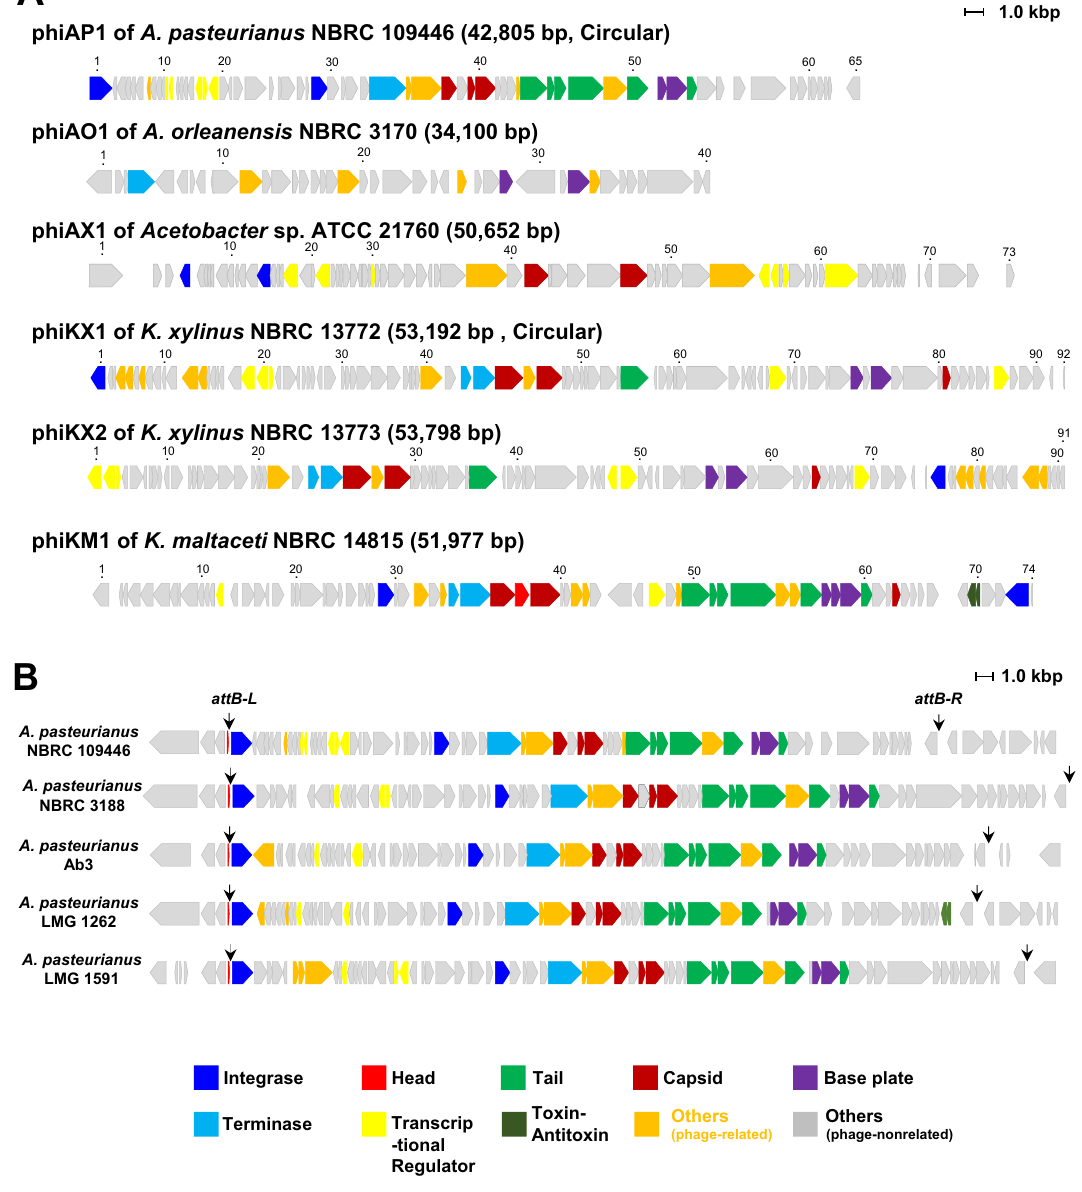
Figure 2. Schematic representation of temperate phage genomes in AAB. ( A ) Genome structure and gene organization of the temperate phages determined in this study. Number above arrow represent ORF number in each temperate phage (annotations for each gene product are shown in Table S4). Numbers in parentheses indicate the genome size and structure of the phages. ( B ) Distribution of phiAP1-like prophage elements in the genomes of A. pasteurianus strains. Downward arrowheads indicate the putative attB-L and attB-R Figure 2A shows the predicted gene organization based on phage genome information. Genome sizes range from 34,100 to 53,798 bp. Circular genome were confirmed in phiAP1 and phiKX1. The molecular G + C content of each genome is 52.4% for phiAP1, 61.4% for phiAO1, 56.0% for phiAX1, 60.2% for phiKX1, 60.0% for phiKX2, and 62.2% for phiKM1 (Table S4). The molecular G + C contents of A. pasteurianus IFO 3283–01 are 50. 7% in the chromosome and 55.8% in the six plasmids 17 , and that of K. xylinus E25 are 62.6% in the chromosome and 57. 8% in the five plasmids 18 . The G + C contents of the six phages lie in the between the values of chromosome and plasmids in both genera. In each of the phage genomes, open reading frames (ORFs) were found: 65 in phiAP1, 40 in phiAO1, 72 in phiAX1, 91 in phiKX1, 90 in phiKX2, and 73 in phiKM1 (Fig. 2A and Table S4). Most genes are predicted to be composed of an operon structure, because the initiation codon and stop codon of translation are close or overlapped in the ORFs.